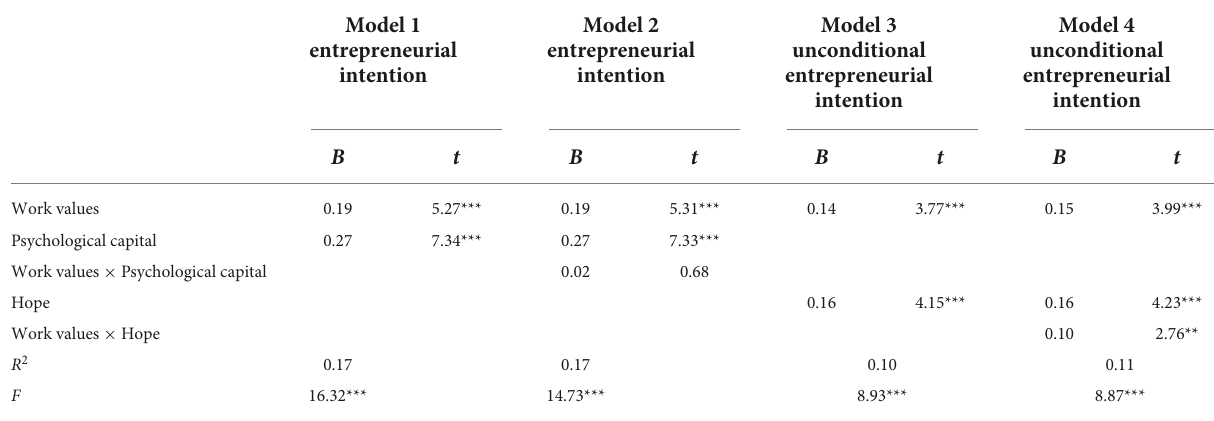
TABLE 4 Validation of moderation effects.